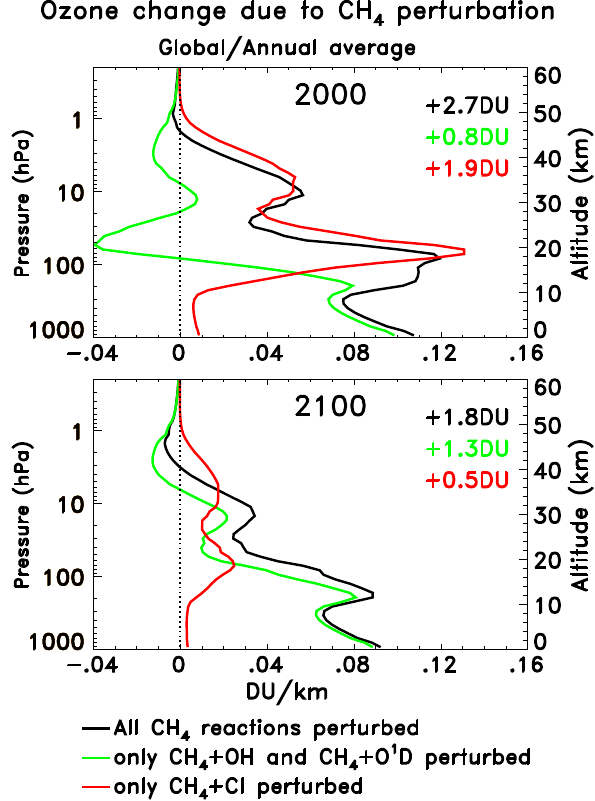
Fig. 9. Vertical profiles of the annual and global averaged steady state ozone change (DUkm − 1 ) due to a 0.5ppmv CH 4 perturbation for year 2000 (top) and year 2100 (bottom). The black curves show simulations with all CH 4 reactions (reactions with O ( 1 D ) , OH, and Cl) using perturbed CH 4 . The green curves show simulations using perturbed CH 4 for reactions with O ( 1 D ) and OH, with unperturbed CH 4 used for the reaction CH 4 + Cl. The red curves show simulations using perturbed CH 4 for the reaction CH 4 + Cl with unperturbed CH 4 used for reactions with O ( 1 D ) and OH. The total column responses for each case are listed in the upper right corner of each panel.